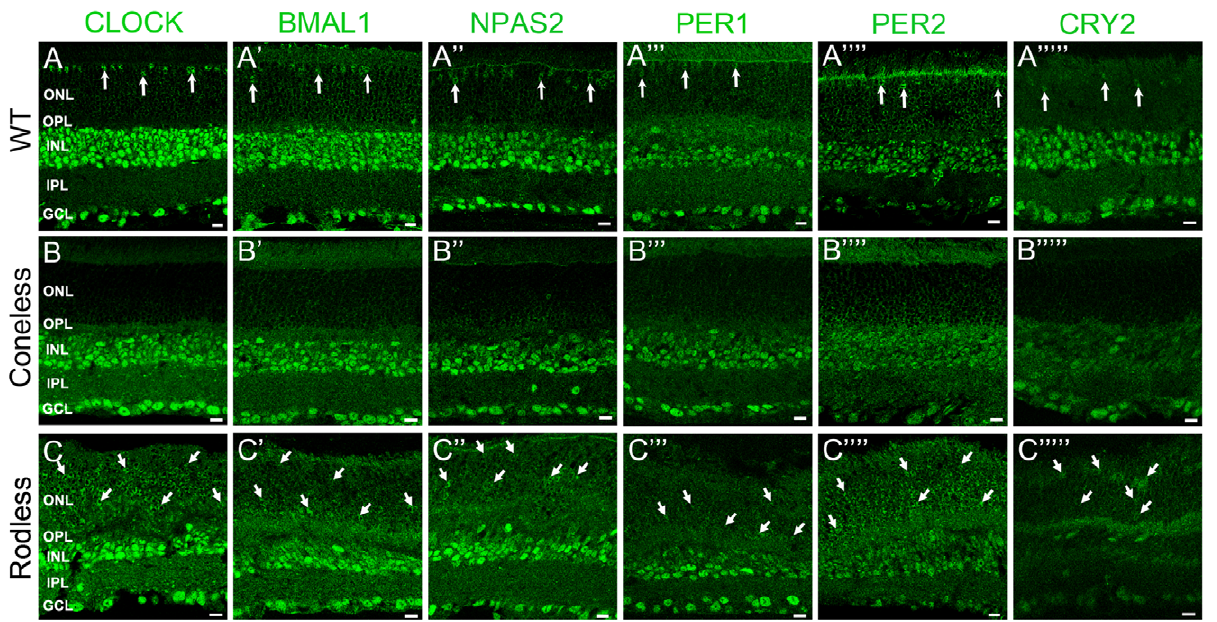
Figure 6. Core circadian clock protein expression in wild-type, coneless and rodeless retinas. Typical examples of vertical sections of wild-type C57Bl/6J ( A–A’’’’’ ), coneless ( B–B’’’’’ ), and rodeless ( C–C’’’’’ ) retinas immunolabeled for each of the following core clock proteins: CLOCK ( A– C ), BMAL1 ( A’–C’ ), NPAS2 ( A’’–C’’ ), PER1 ( A’’’–C’’’ ), PER2 ( A’’’’–C’’’’ ), and CRY2 ( A’’’’’–C’’’’’ ). Retinal tissue was collected around ZT09. For a given clock protein antibody, confocal settings were adjusted on the brightest picture and the 2 other sections were taken at the same settings. Note that clock protein expression in the outer nuclear layer (ONL) is detected in a few cells in the wild-type retina (vertical arrows) and in most cells in the rodless retina (oblique arrows), but is very weak in the coneless retina. OPL: outer plexiform layer; INL: inner nuclear layer; IPL: inner plexiform layer; GCL: ganglion cell layer. Optical sections 3 6 0.4 m m. Bar is 10 m m.